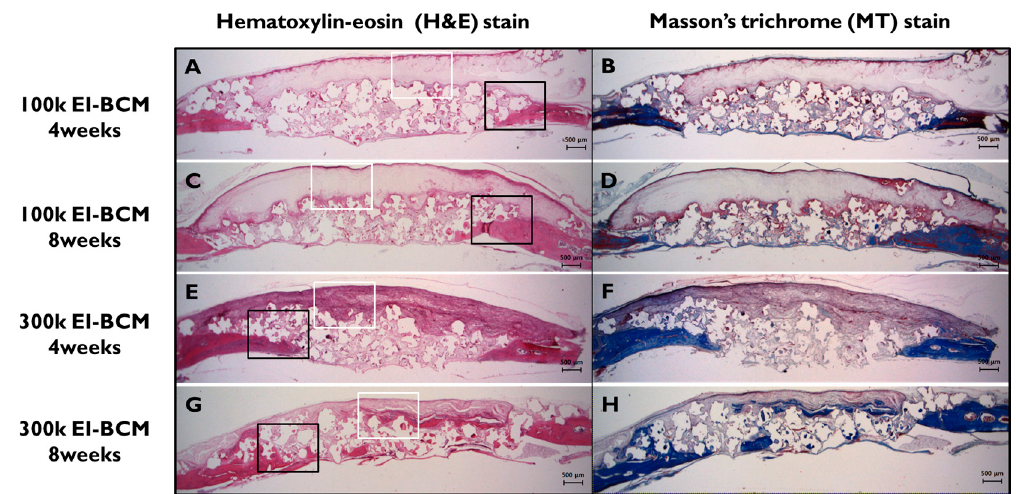
Figure 9. Histological views of defect sites in the 100k and 300k EI-BCM groups. New bone formation and fibrous connective tissue were observed at 4 weeks ( A , B , E , F ) and at 8 weeks after surgery ( C , D , G , H ), and were mainly observed around membranes and old bone. The black rectangles indicate the new bone area in Figure 10 and the white boxes represent the EI-BCMs in Figure 11 (original magnification: 12.5×; ( A , C , E , G ) H&E stained; ( B , D , F , H ) M&T stained).